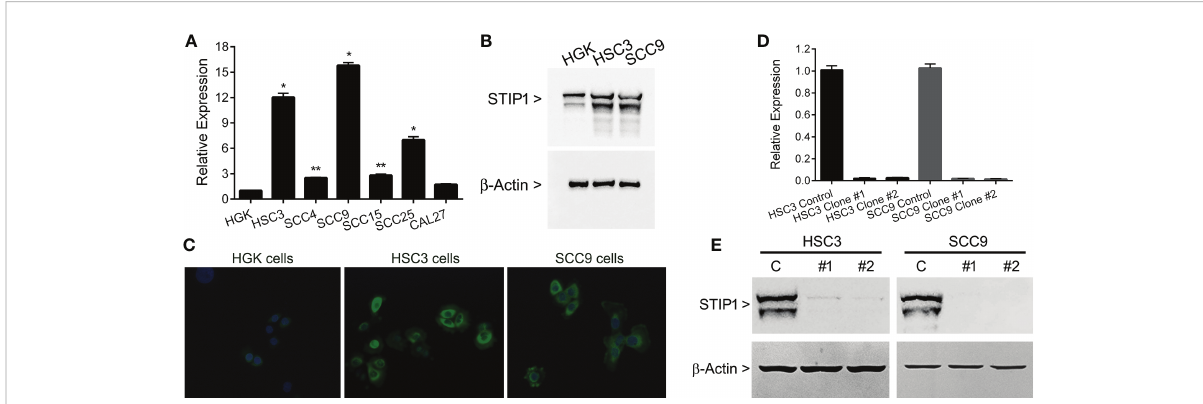
FIGURE 2 STIP1 is overexpressed in OSCC-derived cell lines. (A) Total RNA from the normal human gingival keratinocyte cell line (HGK) and 6 human OSCC cell lines (SCC4, SCC9, SCC15, SCC25, HSC3 and CAL27) were converted in cDNA and subjected to qPCR. The STIP1 mRNA levels were signi fi cantly higher in OSCC cells lines than in HGK, with exception of CAL27. (B) The overexpression of STIP1 was con fi rmed with western blot applying speci fi c antibodies against STIP1 and the housekeeping control b -actin. (C) Immuno fl uorescence analysis revealed an intense staining for STIP1 in OSCC cells, which was mainly found in the perinuclear area. STIP1 knockdown ef fi ciency in HSC3 and SCC9 cells after transduced with lentivirus expressing shRNA sequences against STIP1 (clones #1 and #2) and control as outlined in the methods. A marked reduction in both mRNA (D) and protein (E) levels when compared with control cells was observed. The values represent the average ± SD of three separate experiments. In fi gures (B, C, E) a representative image is shown. *p<0.01,